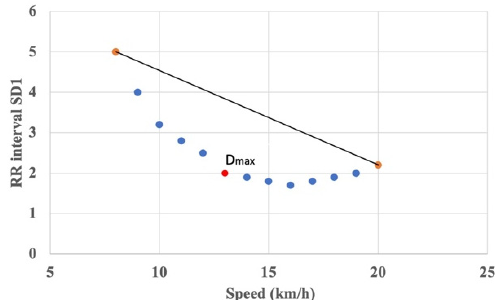
Figure 6. How the threshold (lowest red point) is determined by the Dmax method: it is estimated by the longest perpendicular distance between SD1 (predicted by a third order polynomial function over actual value) from the linear regression calculated with the first and last values of the curve. The speed (km/h) corresponds to the treadmill velocity.